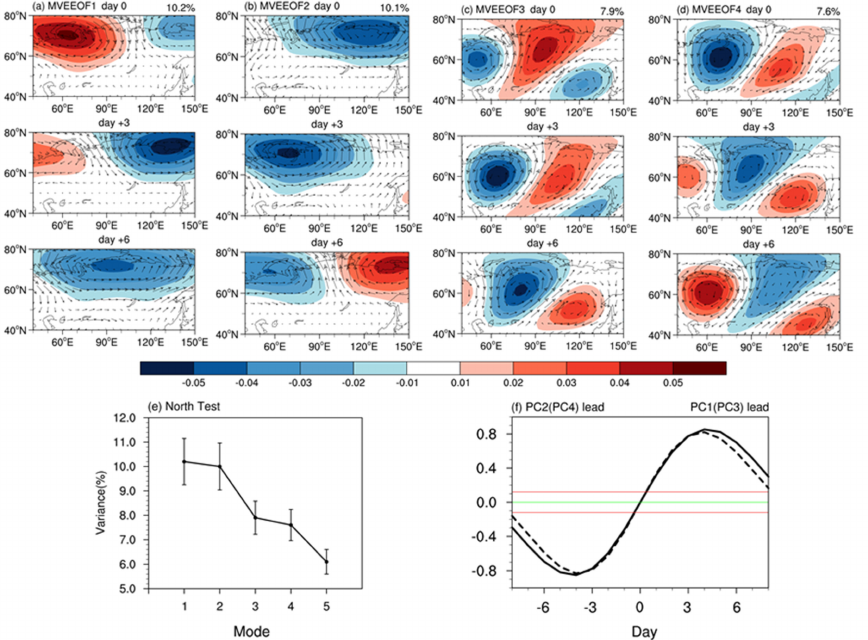
Figure 2. ( a ) The MVEEOF1 of the 10 − 30-day − filtered 250 hPa geopotential height and horizontal wind anomalies in the boreal summer, ( b − d ) as in ( a ), but for MVEEOF2, MVEEOF3, and MVEEOF4, respectively; the MVEEOF with 3 days’ lag is employed; the contribution of each MVEEOF mode to total variance is marked at the upper righthand corner of the appropriate panel. ( e ) The contribution of the first five MVEOF modes (black dot) and their error ranges (black vertical line). ( f ) The lead lag correlation coefficients between PC1 (PC3) and PC2 (PC4), the solid line represents the correlation between PC1 and PC2, and the dashed one represents the correlation between PC3 and PC4; the red one represents a 0.05 significance level.